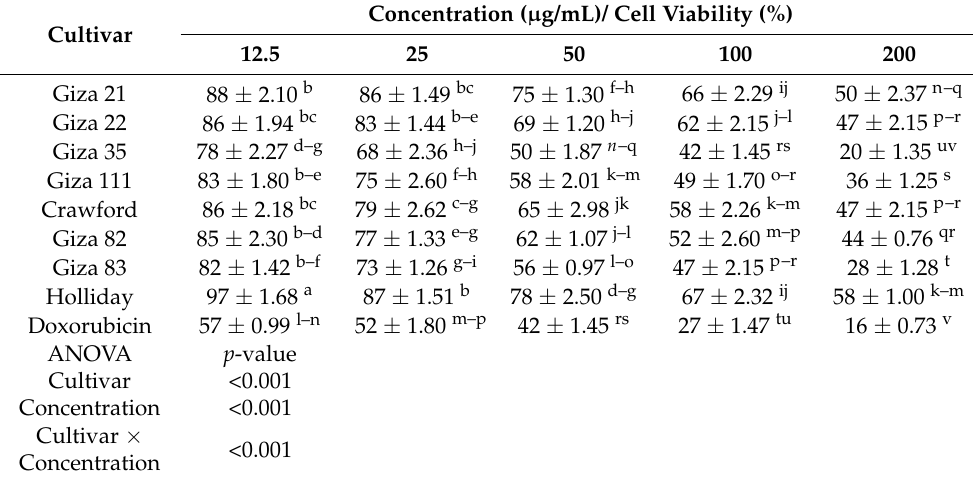
Table 7. The percentage of MCF-7 viability as affected by soybean methanolic extracts at different concentrations (12.5, 25, 50, 100, and 200 µ g/mL) from eight soybean cultivars compared to that of the control